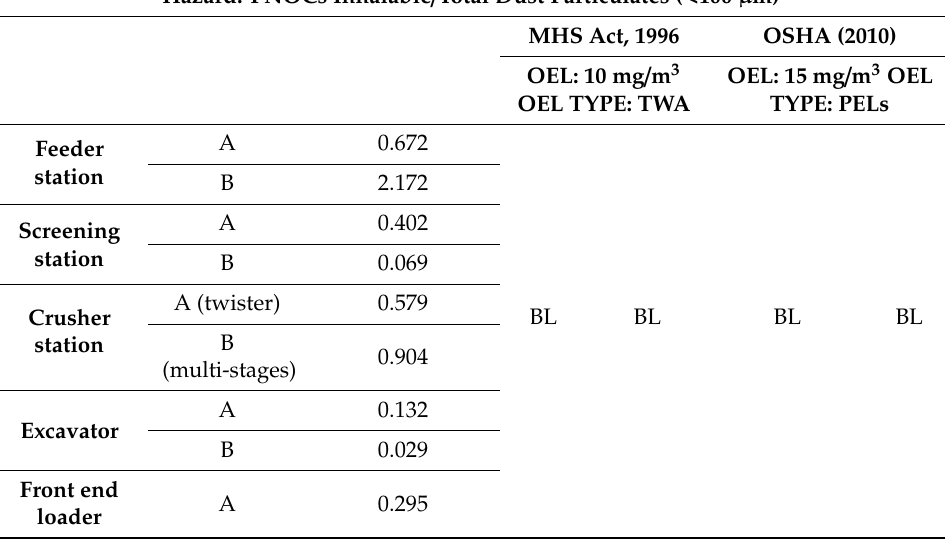
TWA Concentration OEL (mg / m 3 )